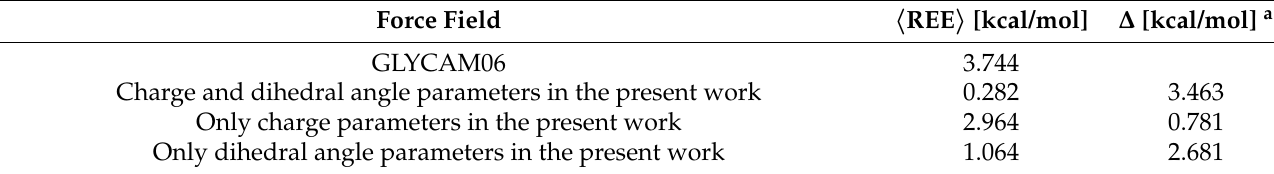
Table 2. Improvement of (cid:104) REE (cid:105) , ∆ , for two parameter sets of GLYCAM06 and the present force